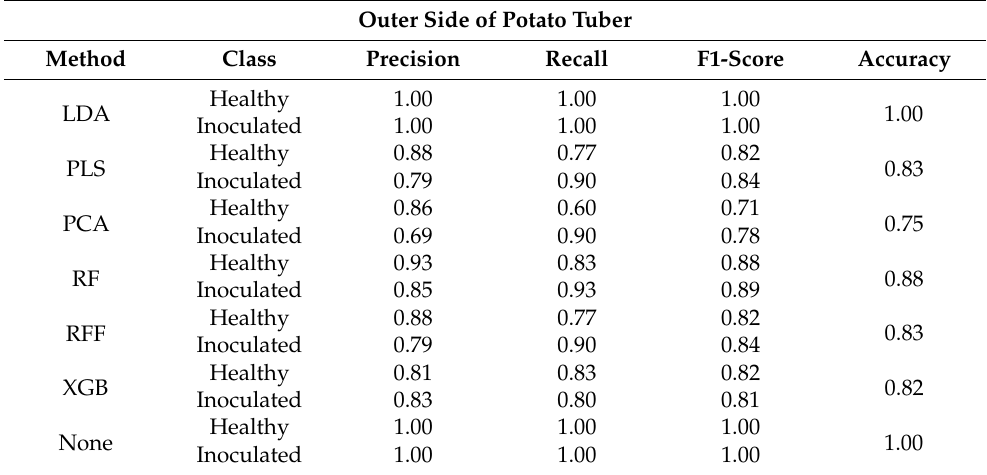
Table 1. Comparison of classification results with only one feature for selected DR methods for outside tuber data.